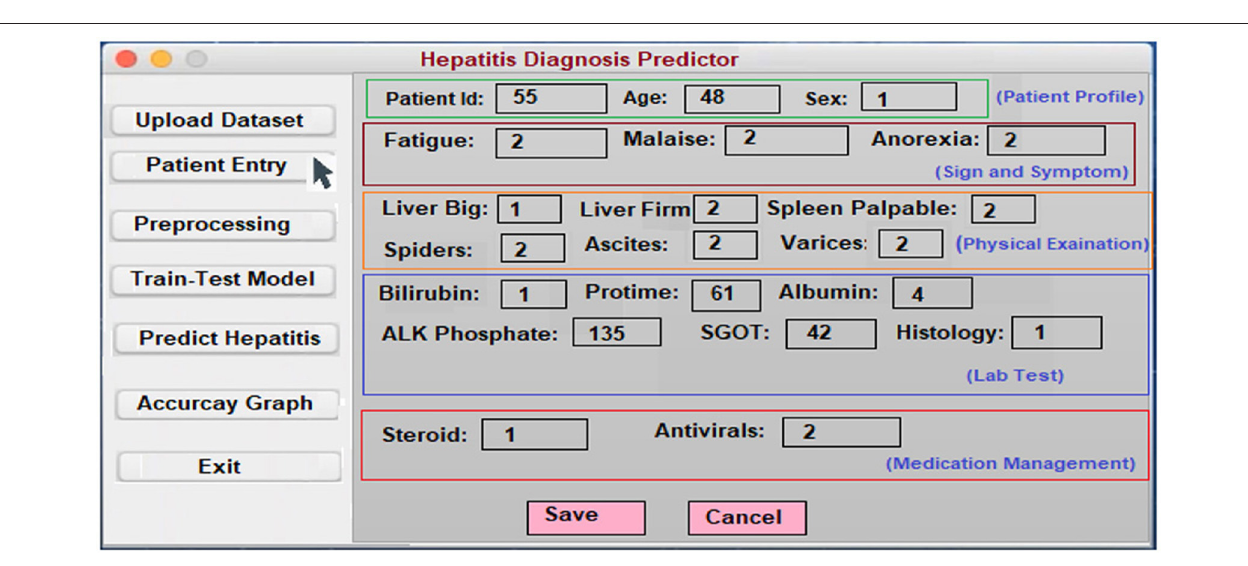
FIGURE 7 | Hepatitis patient survivability classification using the softmax function.